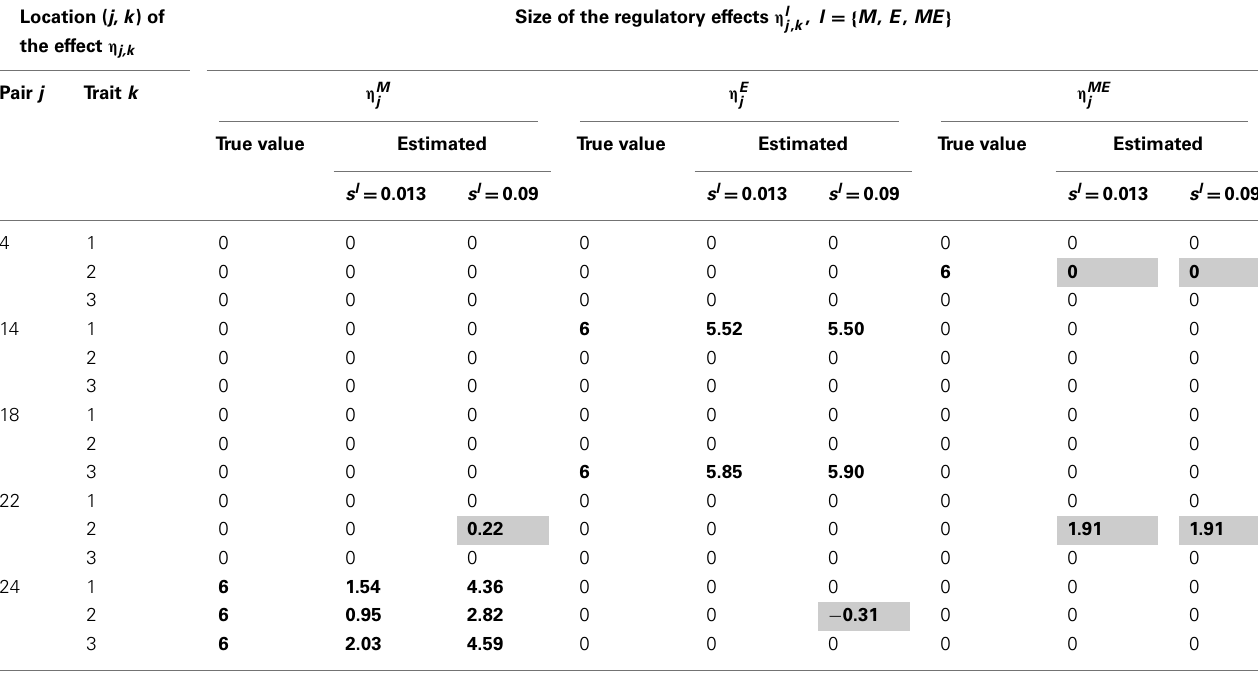
Table 4 |True and estimated (posterior means) cQTL effects under the MD2 version of the HB multi-trait cQTL model with 10% markers and 10% expressions coded as missing and different values of Bernoulli parameter s l . Location ( j , k ) of the effect η